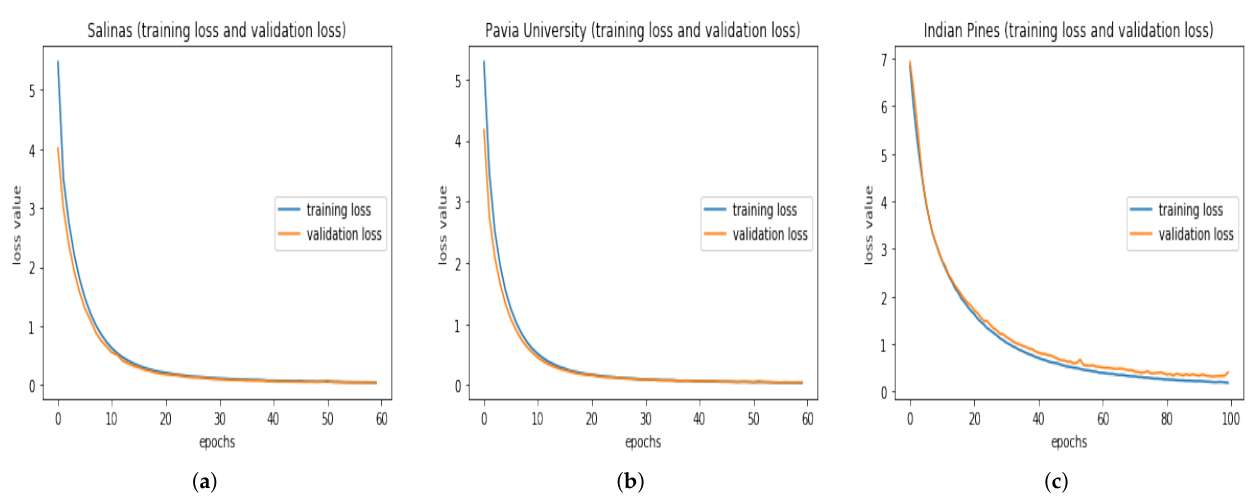
Figure 10. Plots of training loss versus validation loss for all the three datasets used during experi- mentation. ( a ) Salinas (Epochs: 60); ( b ) Pavia University (Epochs: 60); ( c ) Indian Pines (Epochs: